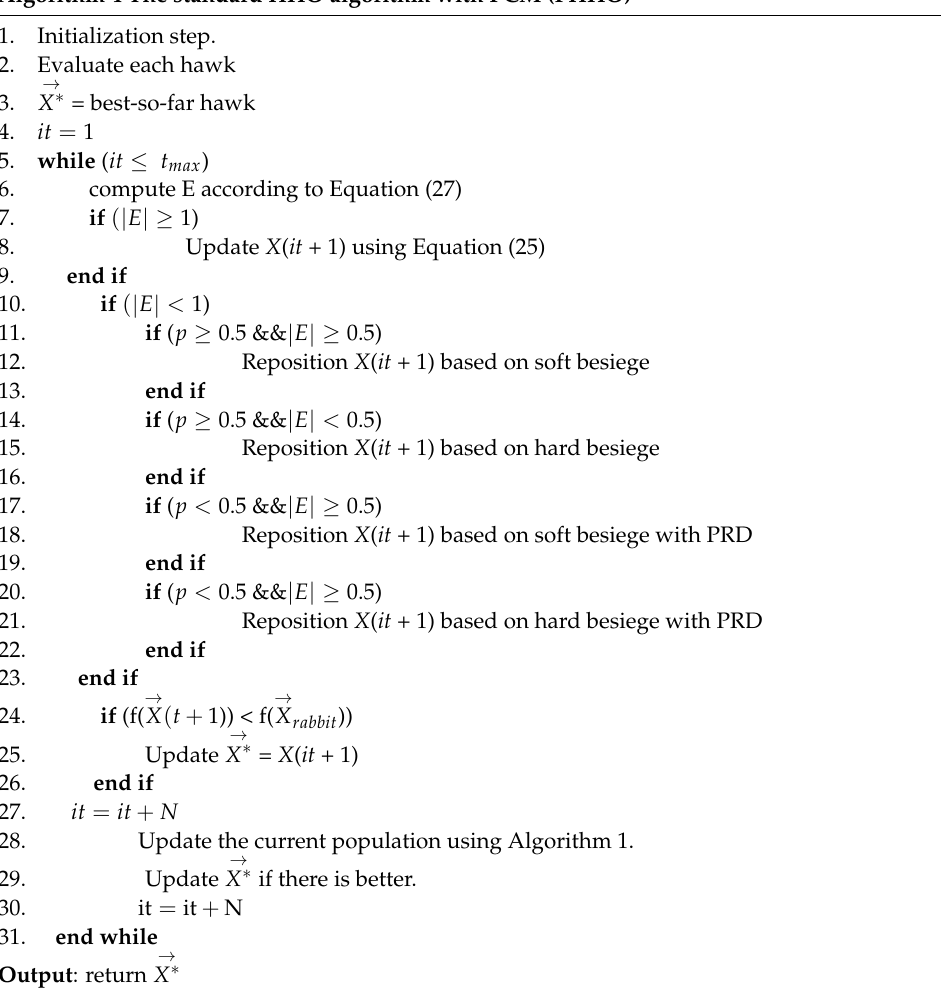
Algorithm 4 The standard HHO algorithm with PCM